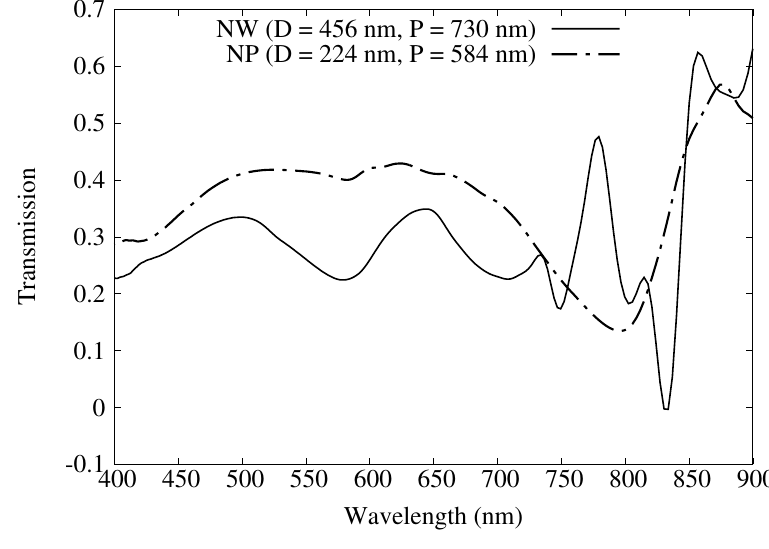
Figure 3. Plot of transmission for nanowell (solid) and nanopost